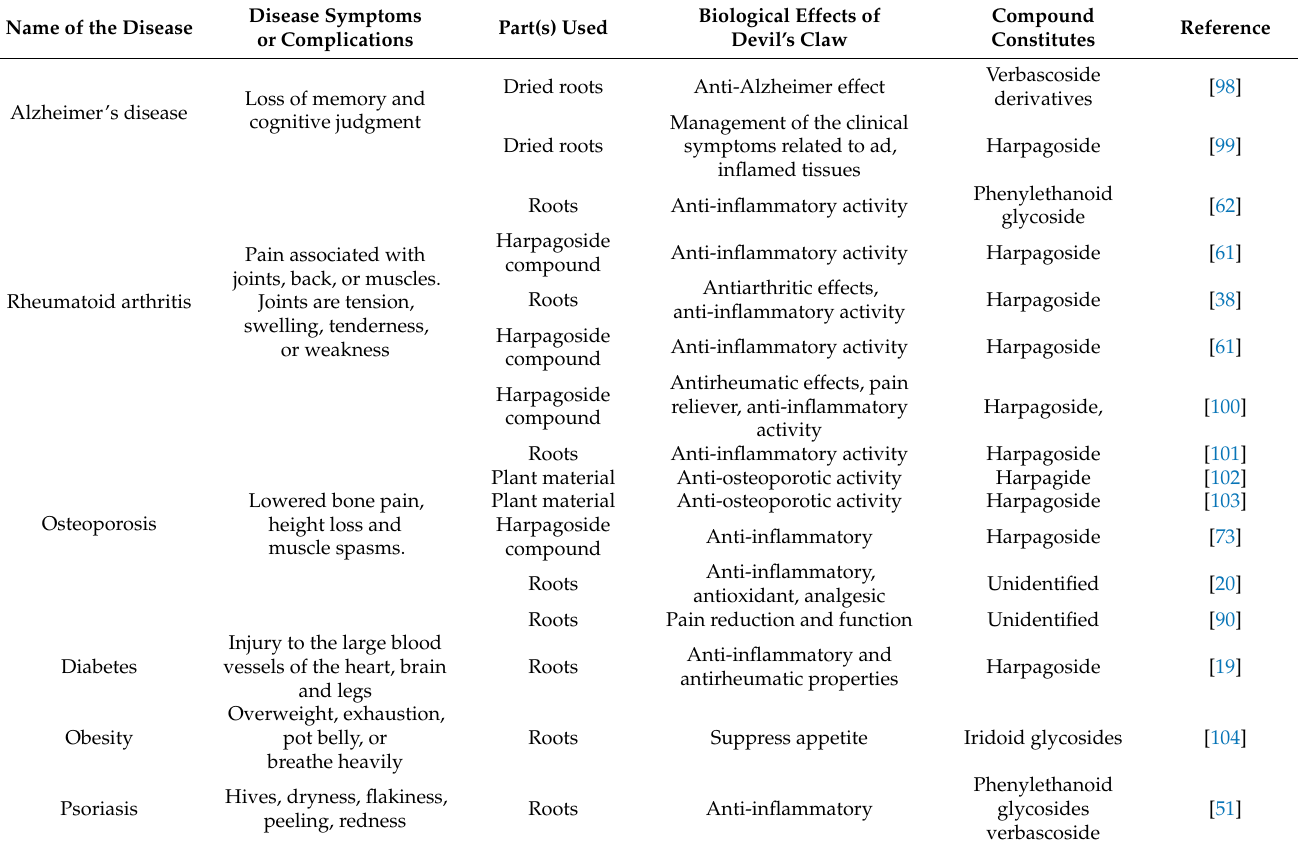
Table 1. Harpagophytum procumbens as an anti-inflammation and pain reliever associated with various